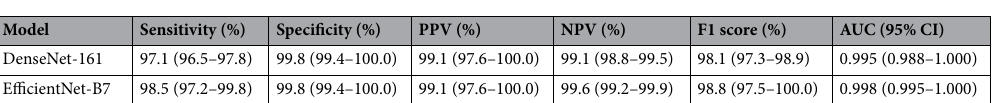
Table 3. Model performances of deep learning models for binary classification discriminating advanced colorectal adenocarcinoma. PPV positive predictive value, NPV negative predictive value, AUC area under the receiver operating characteristic curve, CI confidence